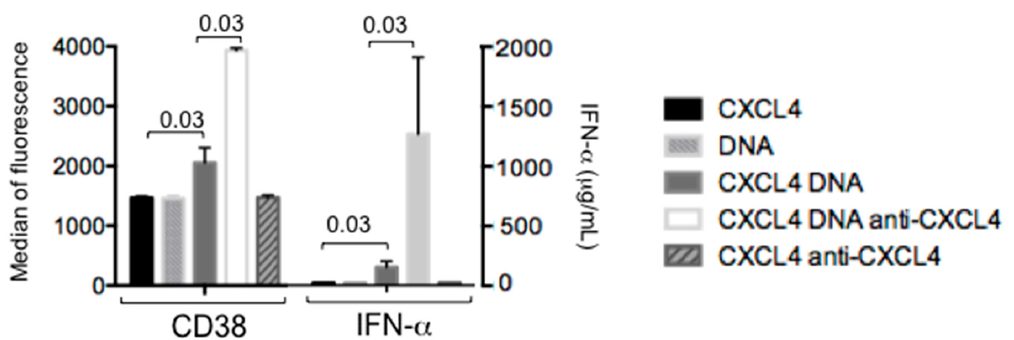
Figure 6. Complexes formed by CXCL4–DNA–anti-CXCL4 antibodies are more effective than CXCL4–DNA complexes at stimulating pDCs. Purified pDCs were treated as indicated (huDNA